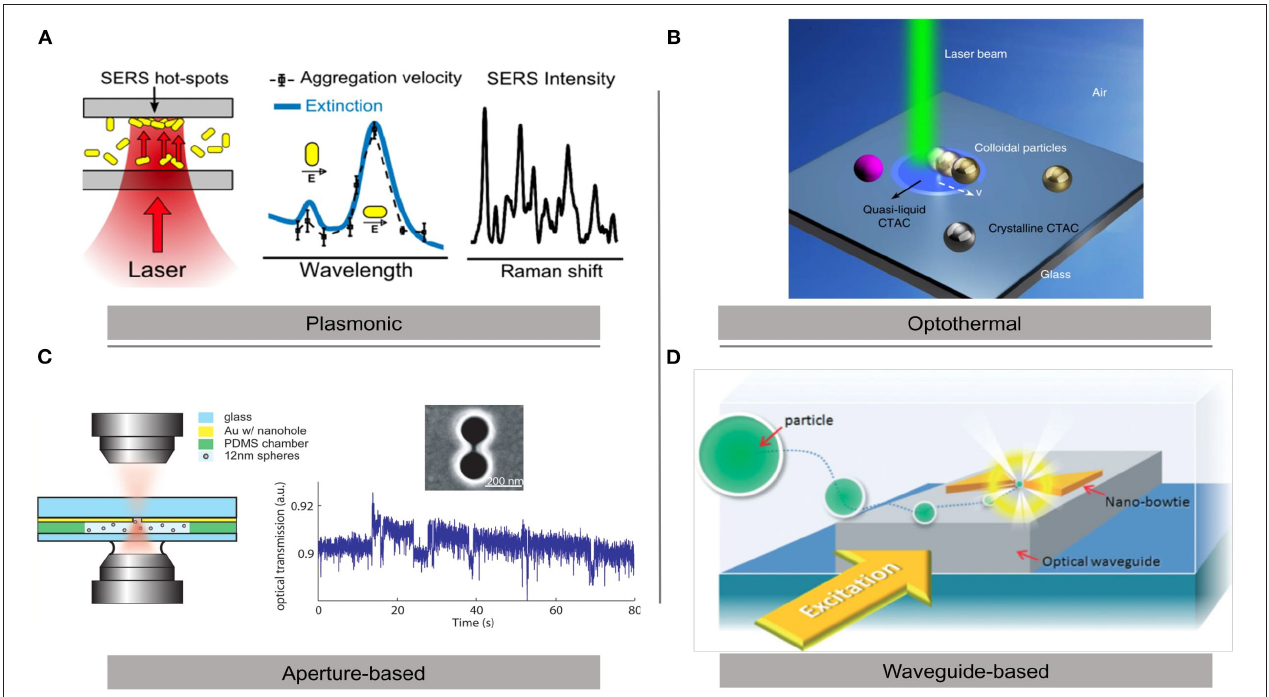
FIGURE 1 | Different schemes for optical trapping of gold nanoparticles. (A) Plasmonic optical tweezers for microfluidics applications (Bernatová et al., 2019). (B) Optothermal optical tweezers for nanomanipulation applications (Li et al., 2019a). (C) Double nanohole aperture optical tweezers for single-molecule studies (Pang and Gordon, 2011). (D) Waveguide-coupled gold bowtie plasmonic tweezers for lab-on-chip developments (Lin et al., 2014). Copyright 2019 ACS, 2019 NR, 2011 ACS, and 2014 RSC.